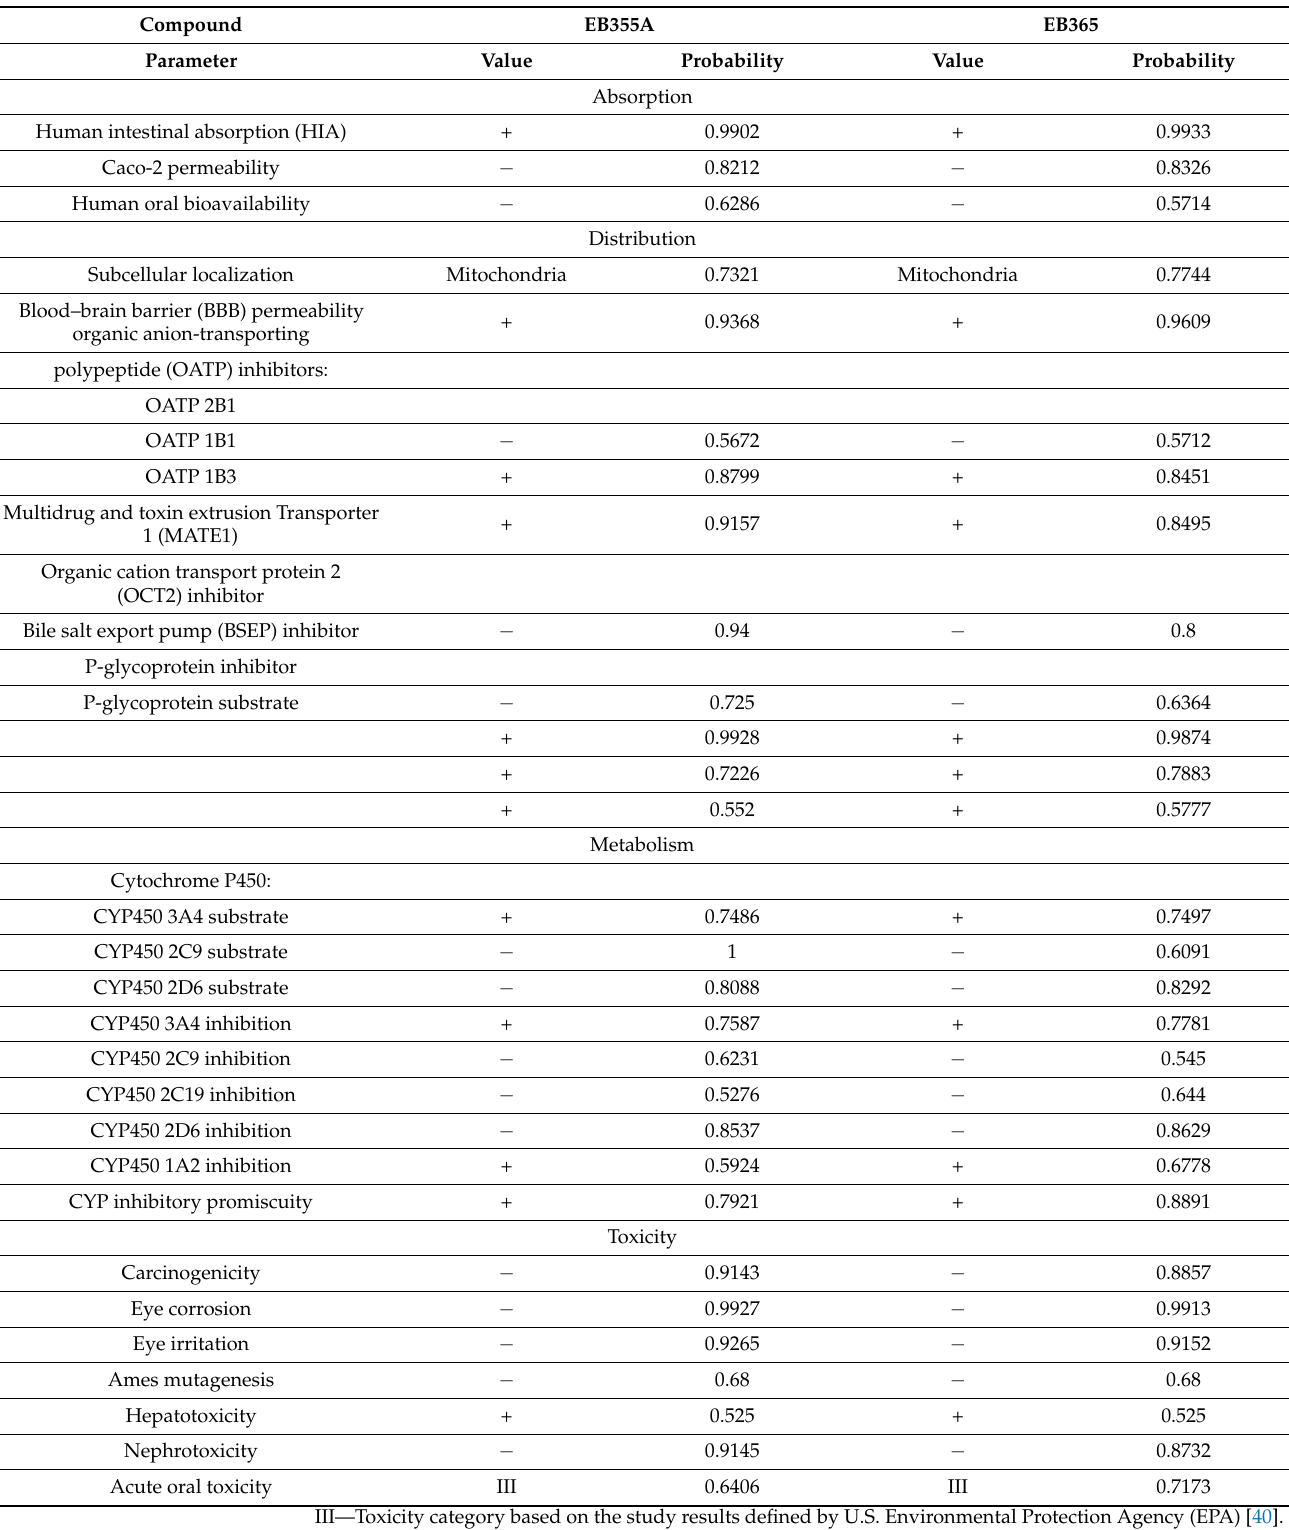
Table 1. Prediction of the ADMET profile of compounds EB355A and EB365 based on computer